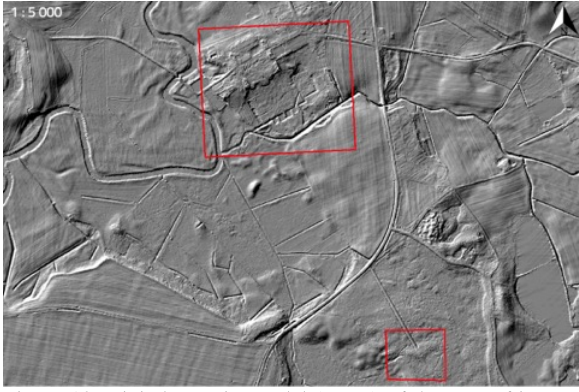
Figure 10. Digital Terrain Model (DTM) of the area of interest – the Manor and the Pyramid in Rapa (framed) (created by M. Szostak).